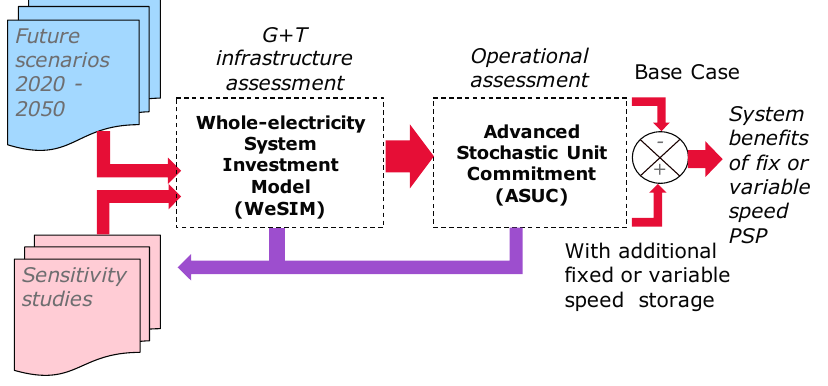
Figure 1. Two-model approach for quantifying the benefits of pumped storage plant (PSP) technologies.